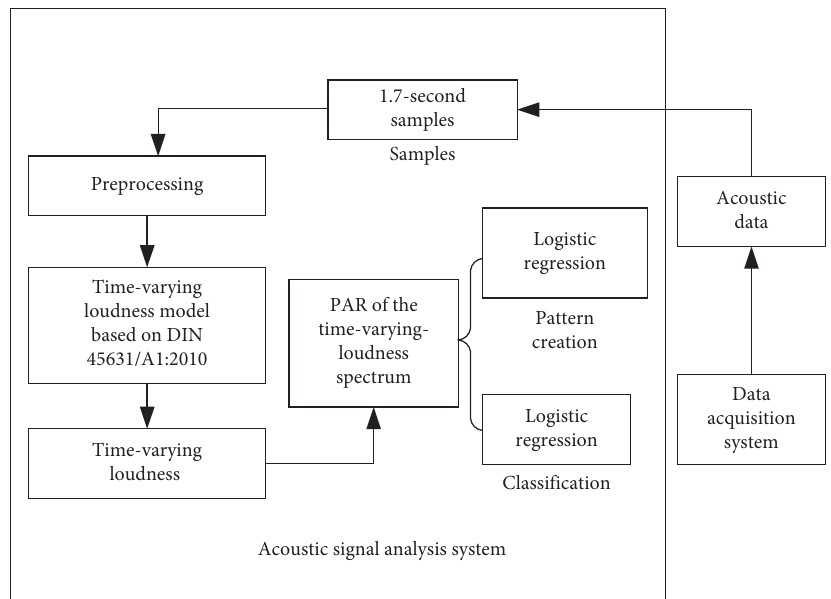
Figure 4: The proposed diagnostic system based on the acoustic